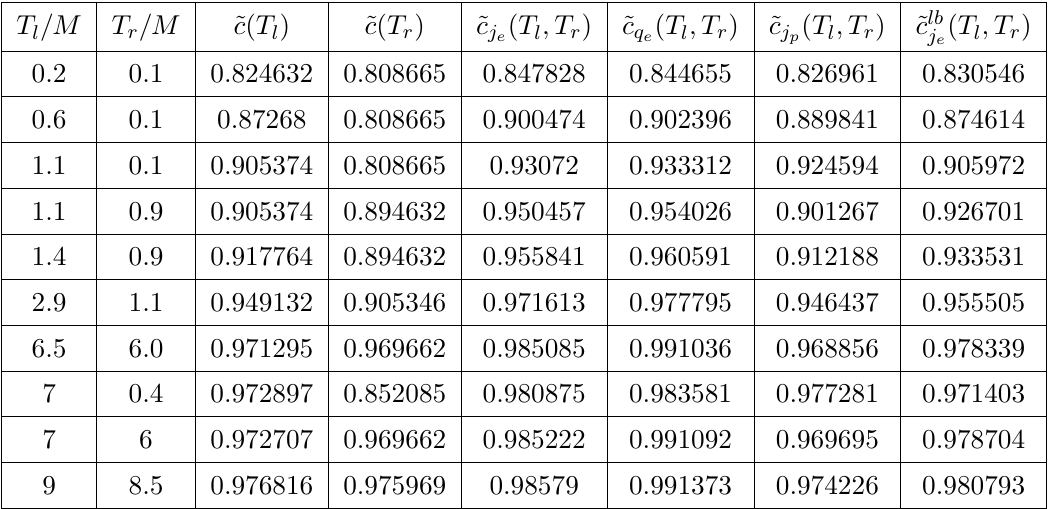
Table 3. The e(cid:11)ective central charges for (left and right) thermal states and the dynamical central charges for the partitioning protocol for various left and right temperatures in the D 4 massless (cid:13)ow, where c UV = 1 and c IR = 0 :